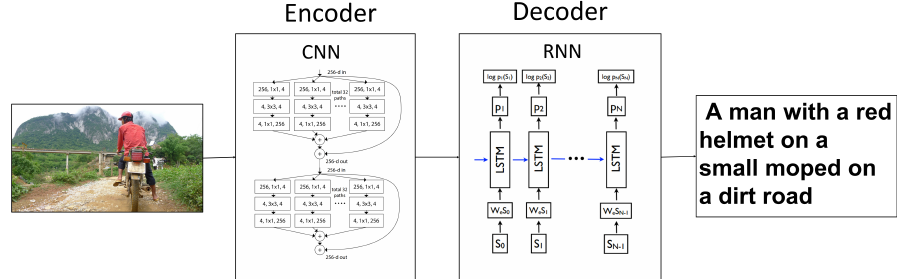
Figure 1. Overview of the image caption model. It includes two parts: a convolutional neural network (CNN) to encode an image into semantic features, and a recurrent neural network (RNN) to decode the input features into a text sequence word-by-word. long-short term memory (LSTM) is a widely used decoder, because original RNN has vanishing and exploding gradients